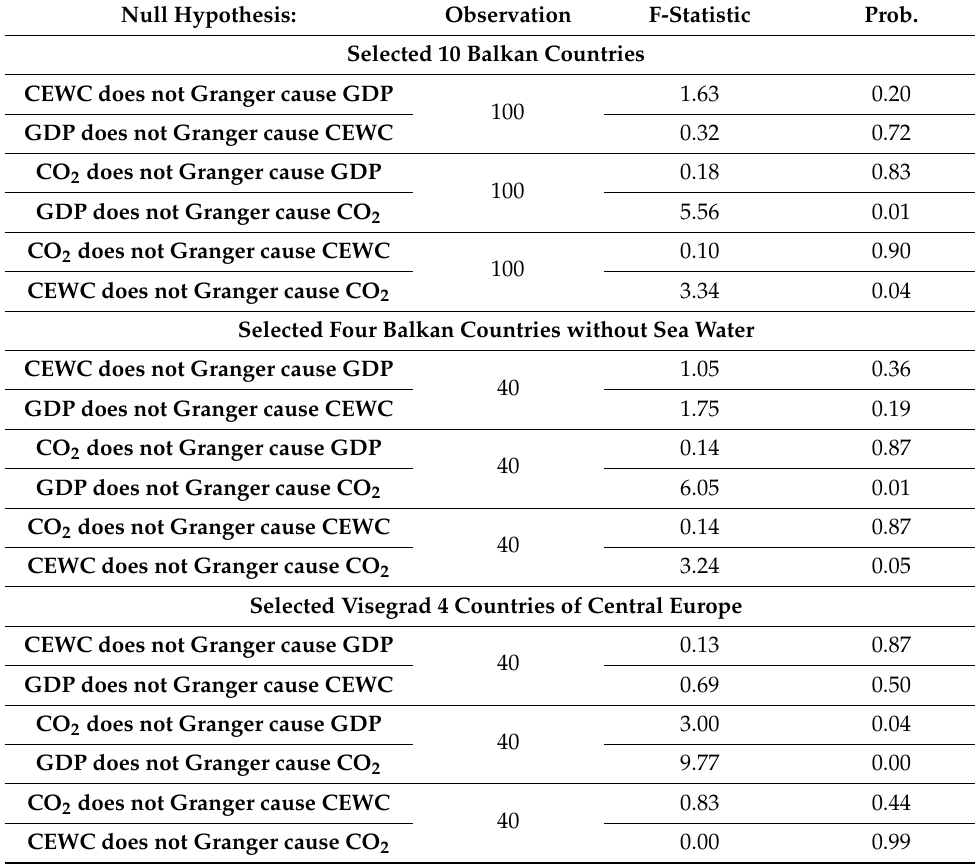
Table 8. Results of the Granger causality